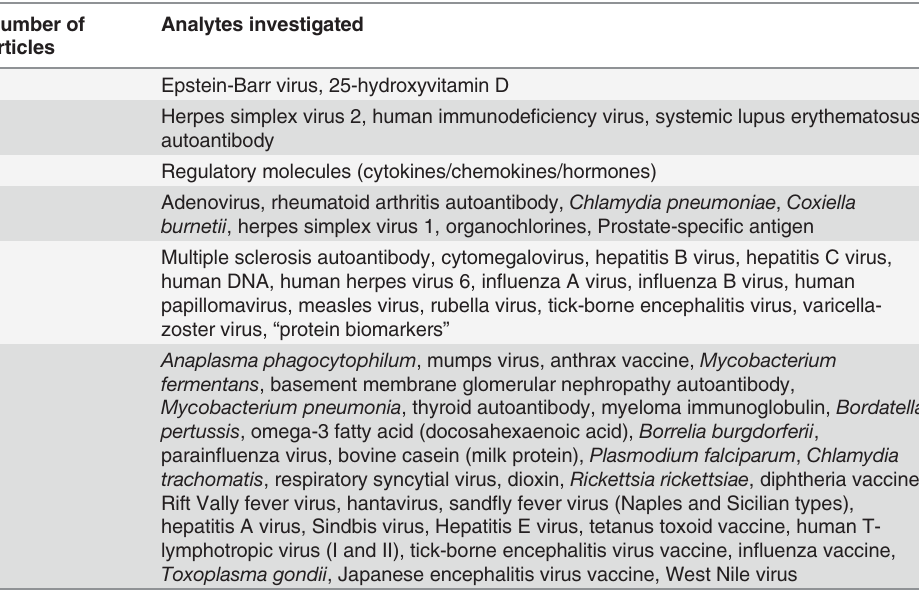
lymphotropic virus (I and II), tick-borne encephalitis virus vaccine, in fl uenza vaccine, Toxoplasma gondii , Japanese encephalitis virus vaccine, West Nile virus a. Unless otherwise speci fi ed, mention of a microbe or vaccine refers to the human antibody to that microbe or induced by the vaccine. Antibodies to the same microbe but with different epitopes are